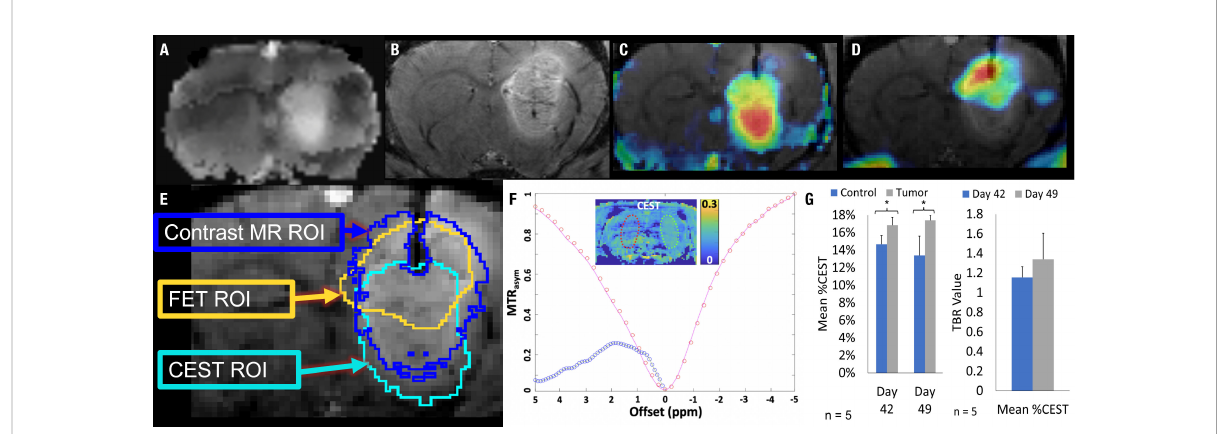
FIGURE 4 18 F-FET PET/CEST MRI of a representative Rag2 -null rat implanted with GBM10, using 3D T1 post-contrast enhancement and CEST MRI and 18 F- FET PET. (A) Coronal view showing a region of signal hyperintensity in the left frontal lobe on a T2-CEST MRI. (B) Coronal view showing a large region of abnormal signal hyperintensity in the left frontal lobe on post-contrast 3D T1 MRI. (C) CEST MRI color map superimposed on the contrasted MRI showing higher intensity (red) in the lower half of the lesion and lower intensity (yellow and blue) in a non-overlapping manner compared with the contrast-enhancing signal in (B, D) 18 F-FET PET color map superimposed over the contrast-enhanced MRI showing higher activity in the upper right-hand corner of the lesion (red and orange) with lower activity involving the upper half of the lesion. (E) The overlap of the 18 F-FET, CEST, and post-contrast T1 ROIs. While there is a slight overlap in all three ROIs, each region is centered differently within the lesion, seen prominently in the differences in areas of high activity (red) seen in (C, D, F) The Z-spectrum, MTR asym , and amide-CEST MRI map of a GBM10 tumor-bearing rat brain are also shown with a 2D control region shown in red and an area of high CEST signal in the region of interest in green. (G) Simultaneously to the serial 18 F-FET PET imaging, fi ve animals were evaluated using serial CEST MRI on days 42 and 49 after implantation. The Mean %CEST of the tumor regions was signi fi cantly elevated (*P < 0.05) relative to control regions on both day 42 and day 49. However, there was no signi fi cant difference in the Mean %CEST of the tumor between days 42 or 49 and no difference in the Mean %CEST TBR between days 42 and